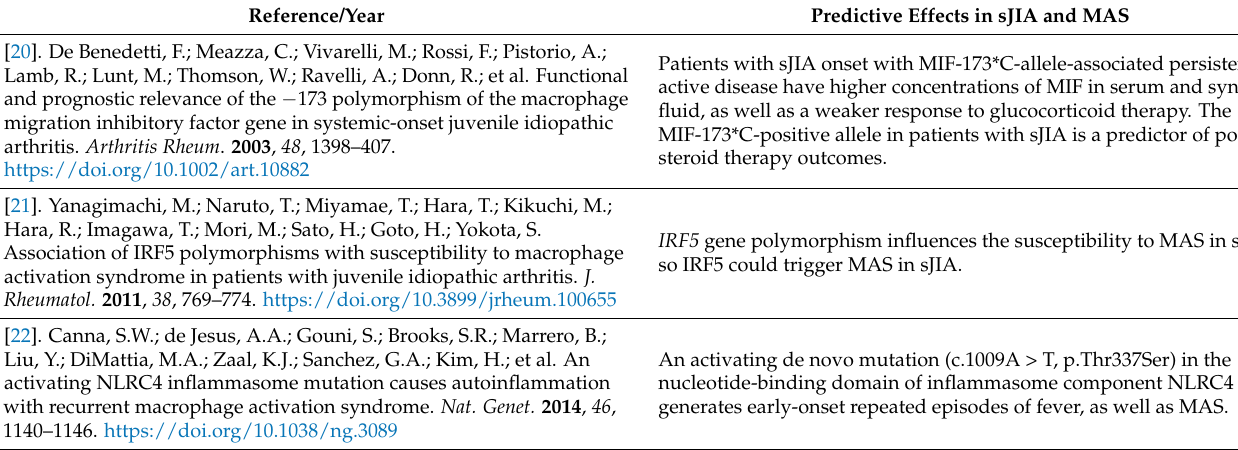
Table 1. Genetic biomarkers proposed for the diagnosis, activity, and prognosis of sJIA and